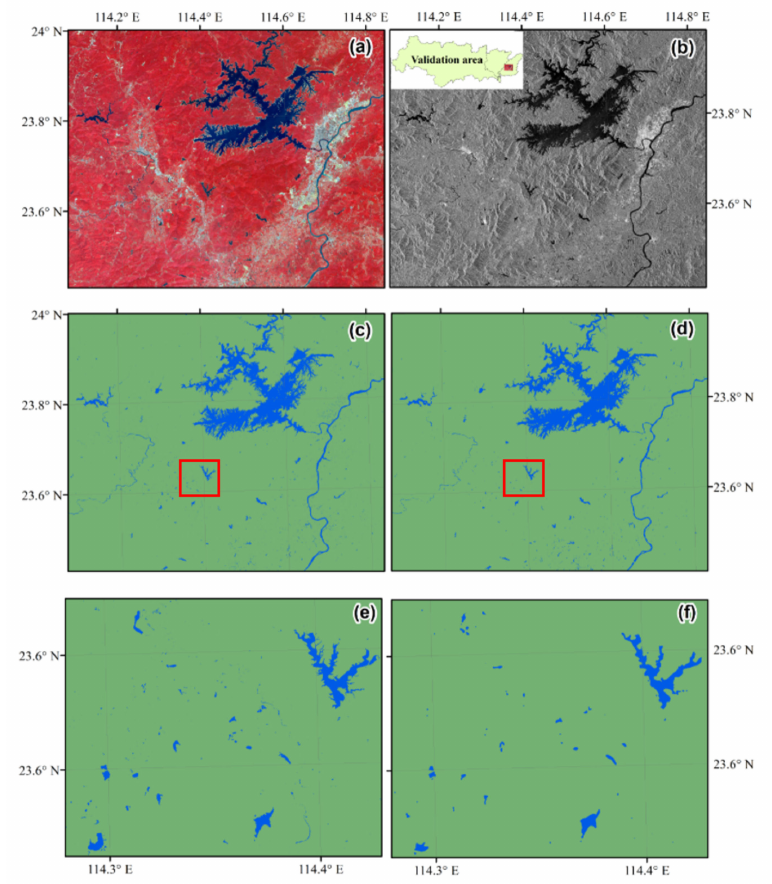
Figure 5. Assessment of the accuracy of the water body extraction based on Sentinel-1 images. ( a ) Sentinel-2 image (R: B8; G:B4; B:B2) on 26/10/2020; ( b ) Sentinel-1 image on 29/10/2020; ( c ) Water body extraction based on Sentinel-2 image; ( d ) Water body extraction based on Sentinel-1 image; ( e ) Region contained by the red box in ( c ); ( f ) Region contained by the red box in ( d ).